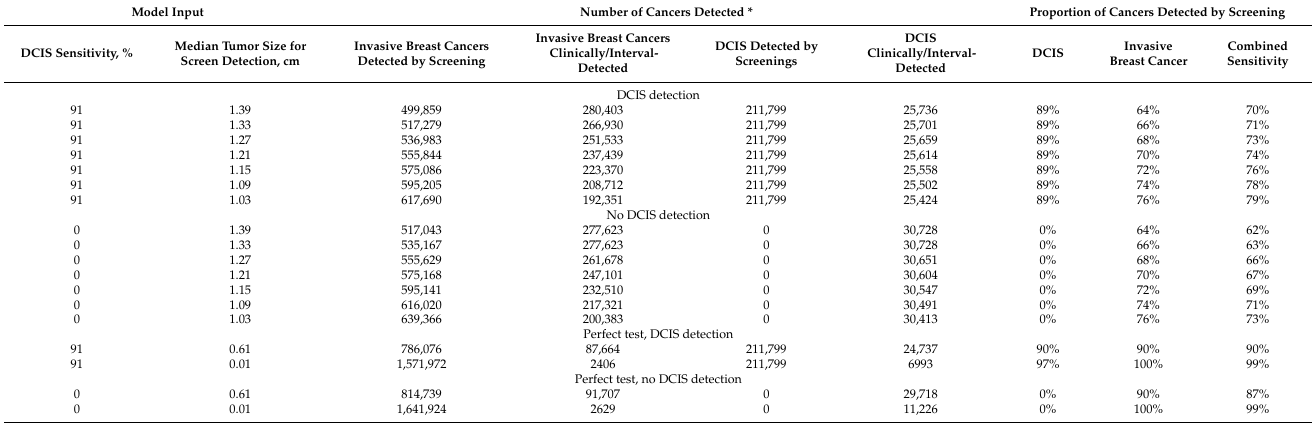
Table 3. Proportion of breast cancers detected by screening.